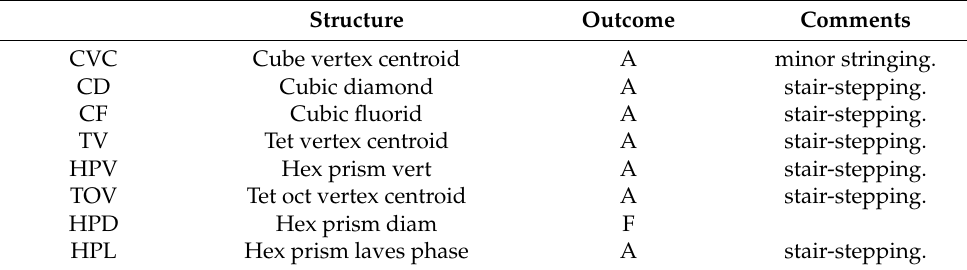
Figure 4. 3D printed lattice structures (scale 2:1, Ender 3, PLA). Lattice structure HPV could not be printed. Table 6. Results of FFF printing tests of larger lattice structures for PLA, scale 2:1.